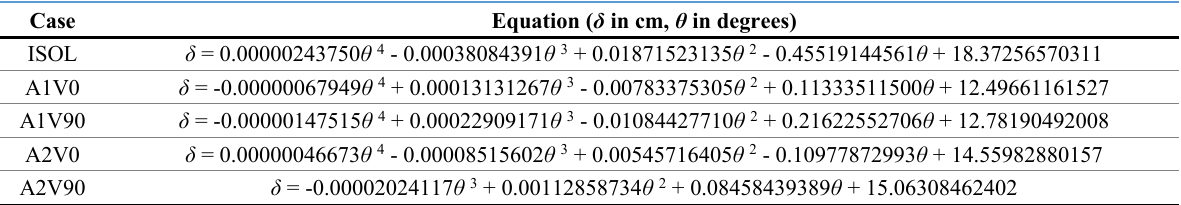
Table 4. Equations for maximum displacement at the top, x-direction.